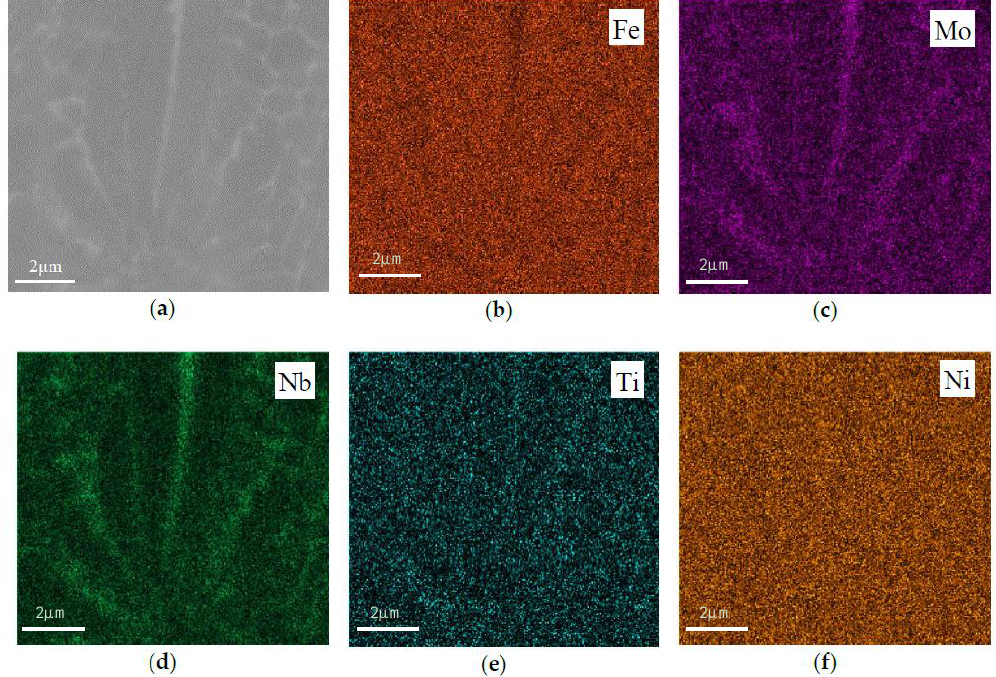
Figure 5. Energy dispersive spectrometer (EDS) elemental mapping of the sectioned IN718 powder particle shown in ( a ); ( b – f ) the elemental maps of Fe, Mo, Nb, Ti and Ni, respectively.